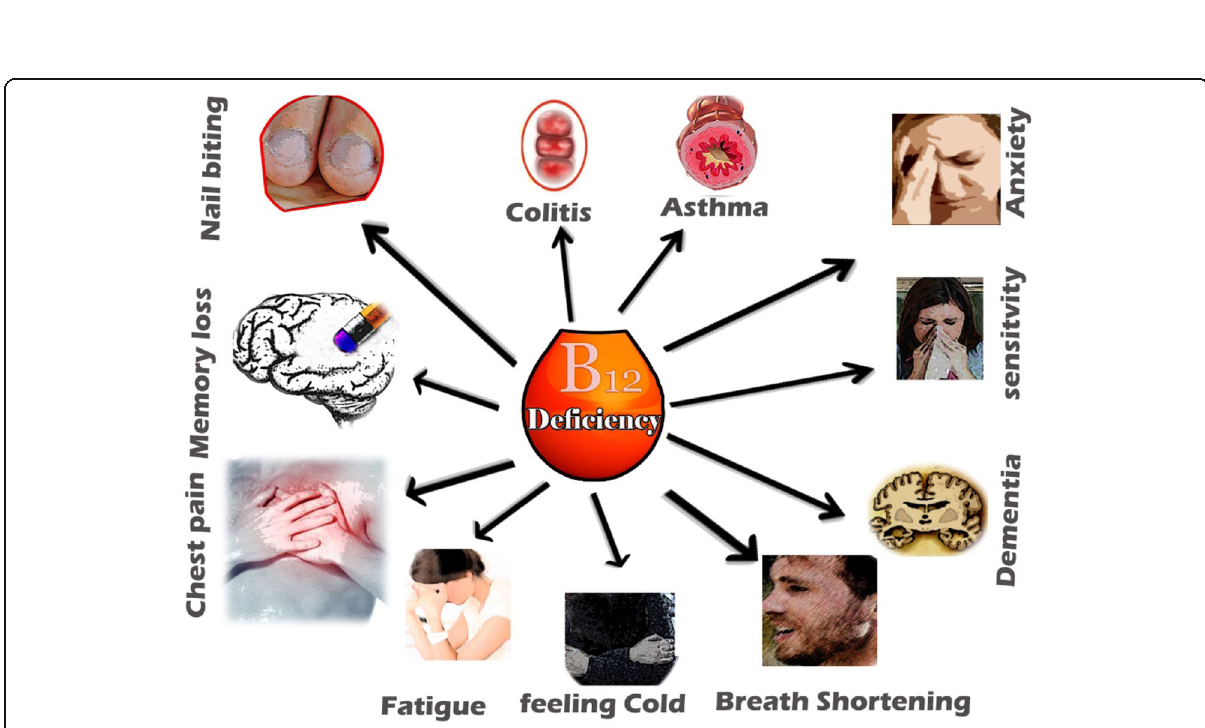
Fig. 4 Signs and symptoms in B 12 Deficiency